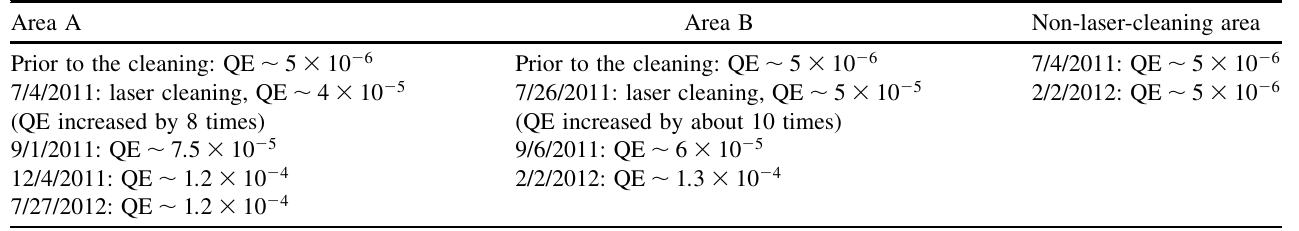
TABLE II. Summary of the QE evolution for the third LCLS cathode. Area